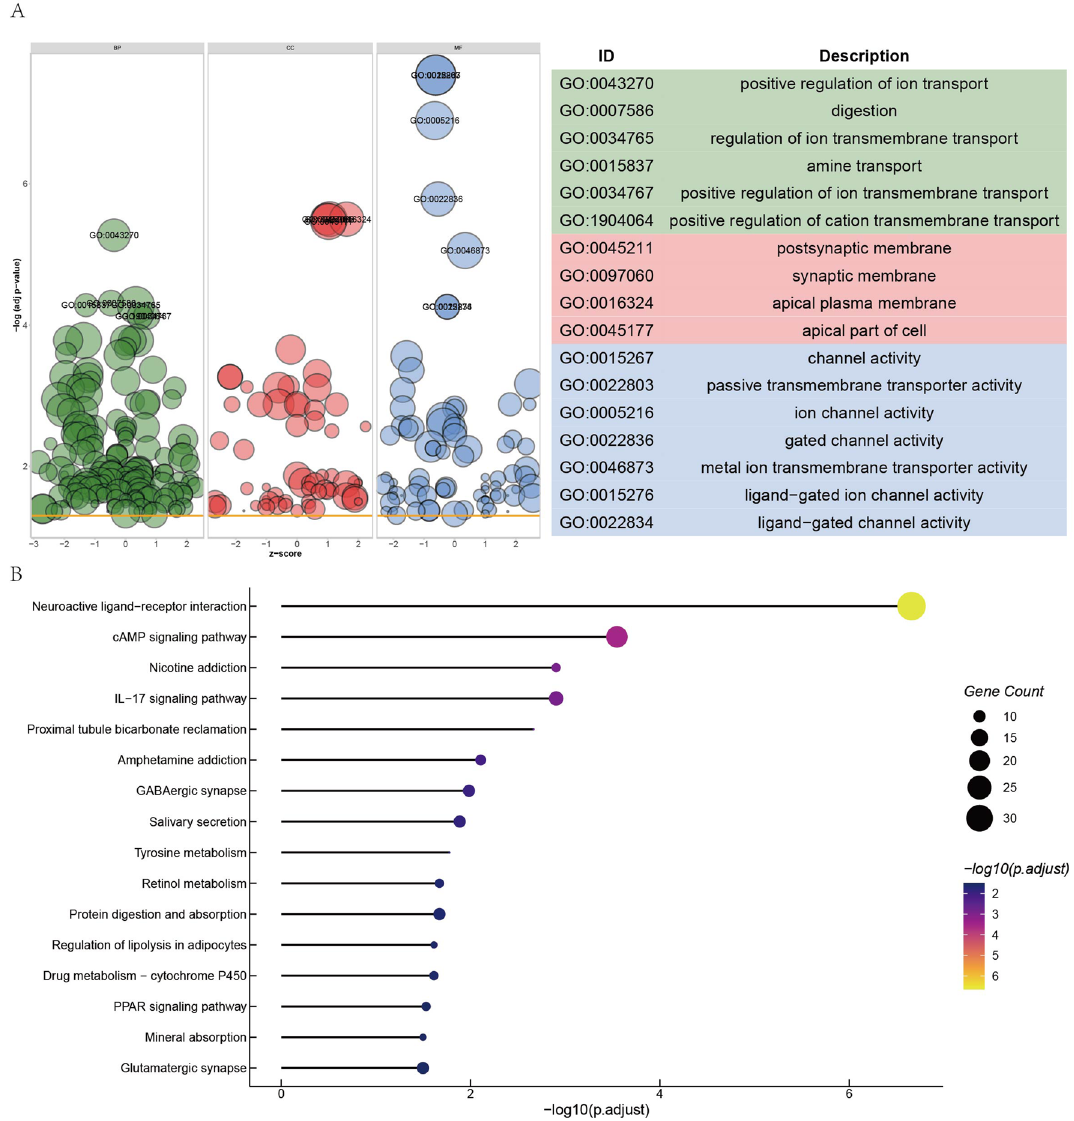
Figure 4. Functional enrichment analysis of DEmRNAs. ( A ) Annotation of MF, BP and CC for DEmRNAs. ( B ) KEGG pathway enrichment analysis of whereas those with lower expression of CTD-3247F14.2 had poor prognostic results. Univariate Cox regression analyses showed the similar result (Fig. 6C). RP1-228H13.5 (hazard ratio = 1.247, P = 0.028) and RP11-384L8.1 (hazard ratio = 1.217, P = 0.001) were identified as risk features, whereas CTD-3247F14.2 (hazard ratio = 0.913, P = 0.010) was identified as a favorable factor. The current study predicted the location of three lncRNAs via lncLocator tool. The prediction results of LncLocator web (Fig. 6D) showed that RP1-228H13.5 was mainly located in cytoplasm, CTD-3247F14.2 mainly located in nucleus, and RP11-384L8.1 mainly located in exosome. Additionally, we verified different expression level of lncRNAs in 112 paired BRCA samples from TCGA database. RP1-228H13.5 was upregulated in tumor samples, whereas CTD-3247F14.2 and RP11-384L8.1 were downregulated in tumor samples (Fig. 6E). Figure 6F exhibited expression levels of 3 lncRNAs between CD24high and CD24low groups and there were obvious dif- ferences between two groups. Comprehensive analysis of the above indicated that RP1-228H13.5 was the hub lncRNA in the ceRNA net- work. Hsa-miR-135a-5p, the target of lncRNA RP1-228H13.5, was comprehensively analyzed. According to survival analysis, hsa-miR-135a-5p was identified as a protective factor (Fig. 7B) and the patients with higher expression level of hsa-miR-135a-5p had better results (Fig. 7A). Moreover, hsa-miR-135a-5p was downregu- lated in the tumor tissues compared with paired normal tissues ( P = 0.0132) (Fig. 7C), and there was significant difference of expression level between CD24 high and CD24 low groups (Fig. 7D). In contrast, another miRNA, hsa-miR-10a-5p, seemed less important. There was no significant relationship between hsa-miR-10a-5p and prognostic results of patients with BRCA, although there was significant difference in differential analysis of